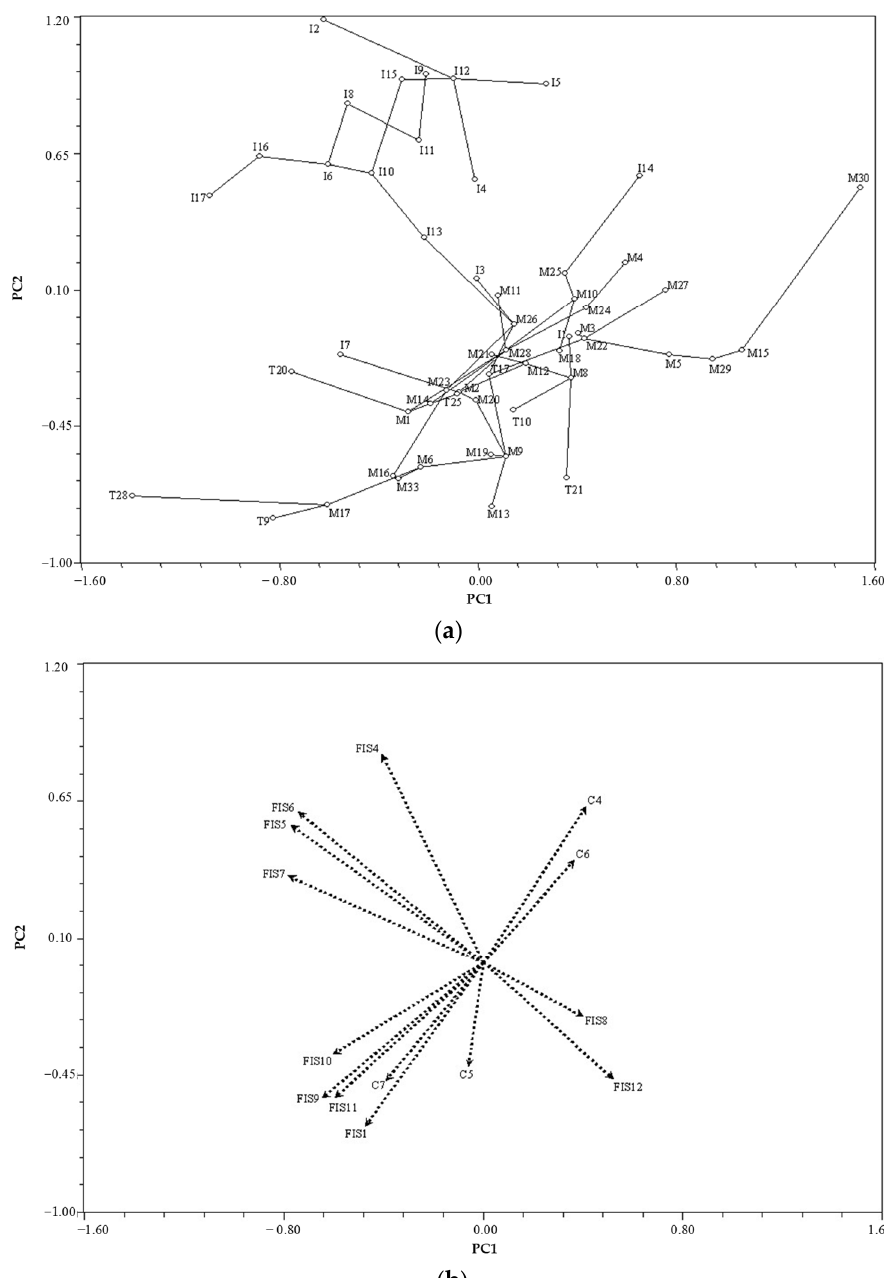
Figure 5. ( a ) PC 1 and PC 2 projection plots of the 54 tropical species (listed in Tables 1 and 3) based on physical wood characteristics (coded in Table 2), overlapped by the MST method (c= 0.92). ( b ) The correlation degree between the variables based on the position of the vector.